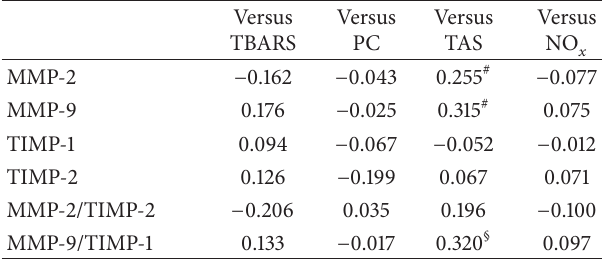
Table 3: Correlations between oxidative parameters and gelatinases in all MS subjects.